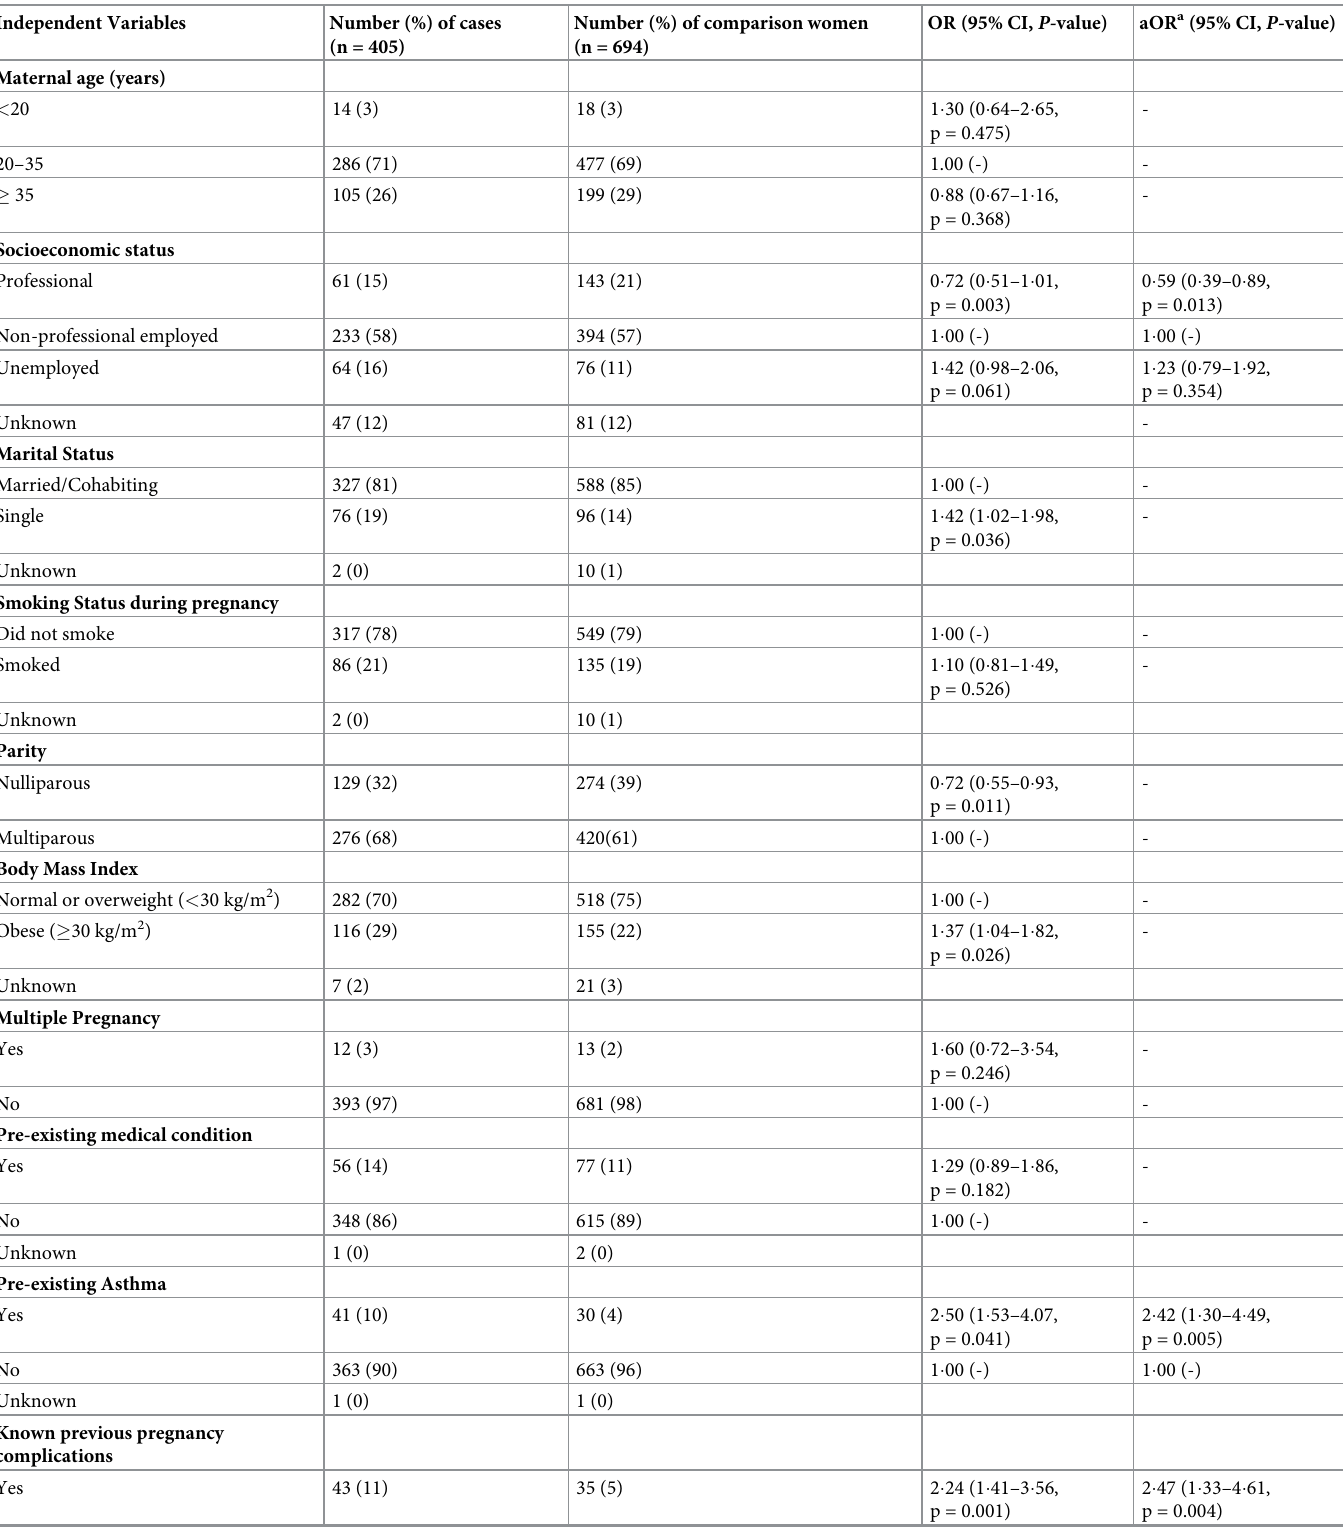
Table 1. Characteristics of case and comparison